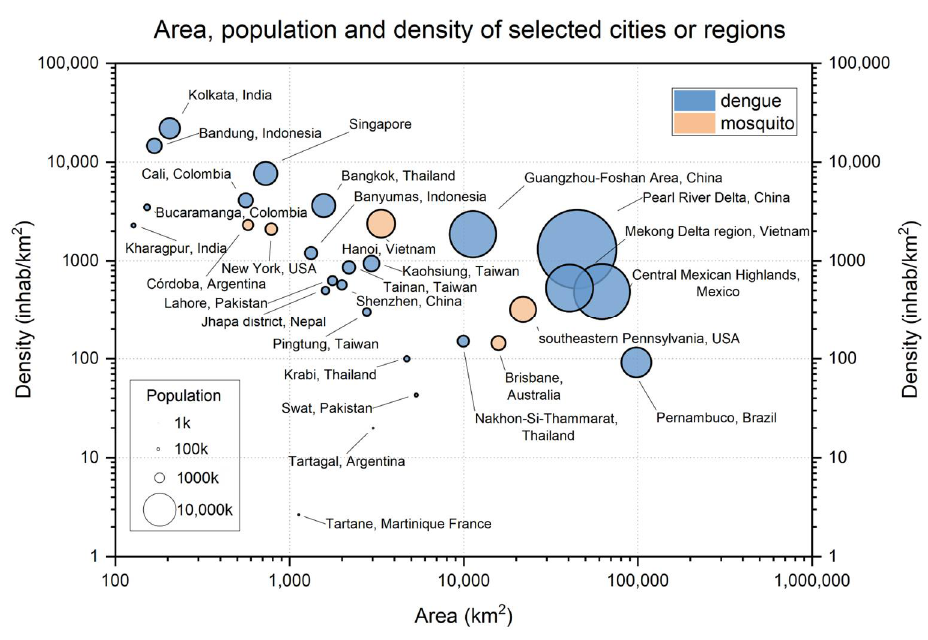
Figure 3. General information about the study area in selected references.